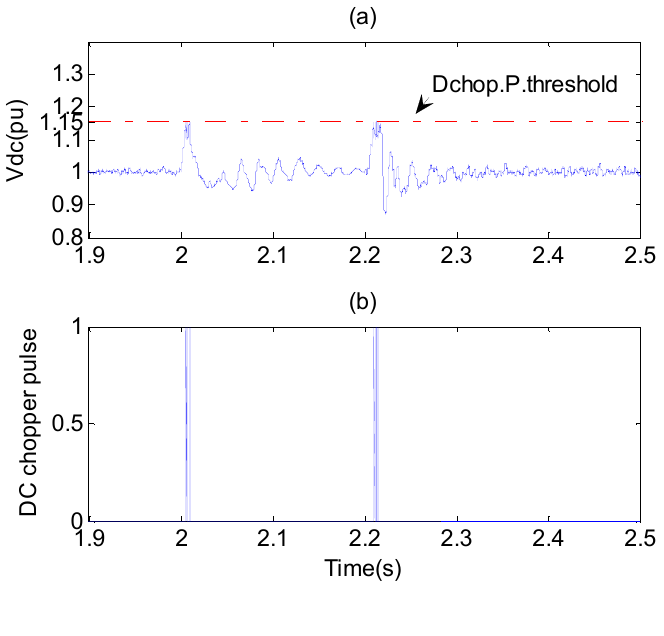
Figure 13. The DC link voltage of case 3: ( a ) DC voltage; ( b ) DC chopper circuit control